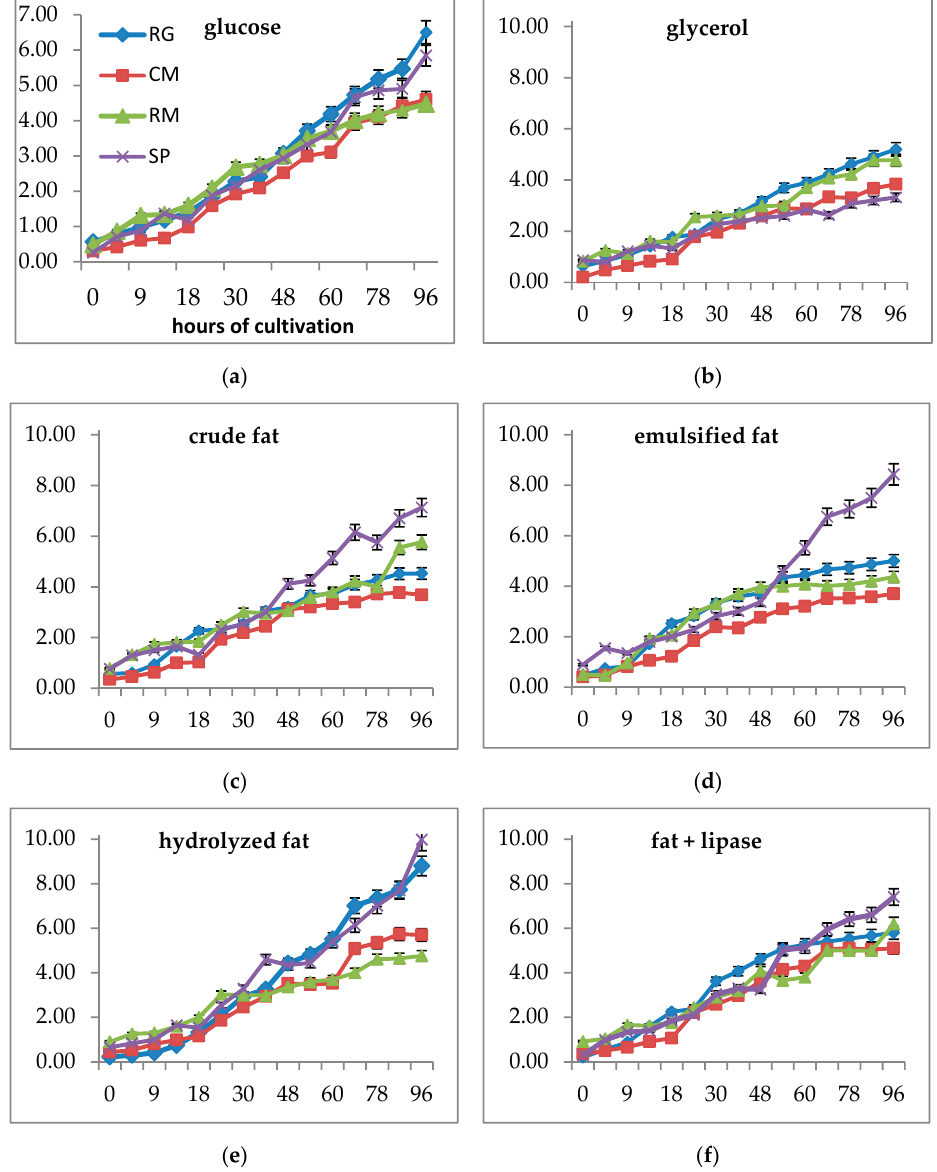
Figure 2. Growth curves of yeast strains cultivated in different media for 96 hours. Biomass production in g/L was measured in the following media: ( a ) Medium with glucose; ( b ) medium with glycerol; ( c ) medium with crude animal fat; ( d ) medium with emulsified fat by Tween 80; ( e ) medium with enzymatically hydrolyzed fat; and ( f ) medium with animal fat and the addition of lipase. Abbreviations: CCY (Culture Collection of Yeasts), RG ( Rhodotorula glutinis CCY 20-2-26), CM ( Cystofilobasidium macerans CCY 10-1-2), RM ( Rhodotorula mucilaginosa CCY 19-4-6), and SP ( Sporobolomyces pararoseus CCY 19-9-6).